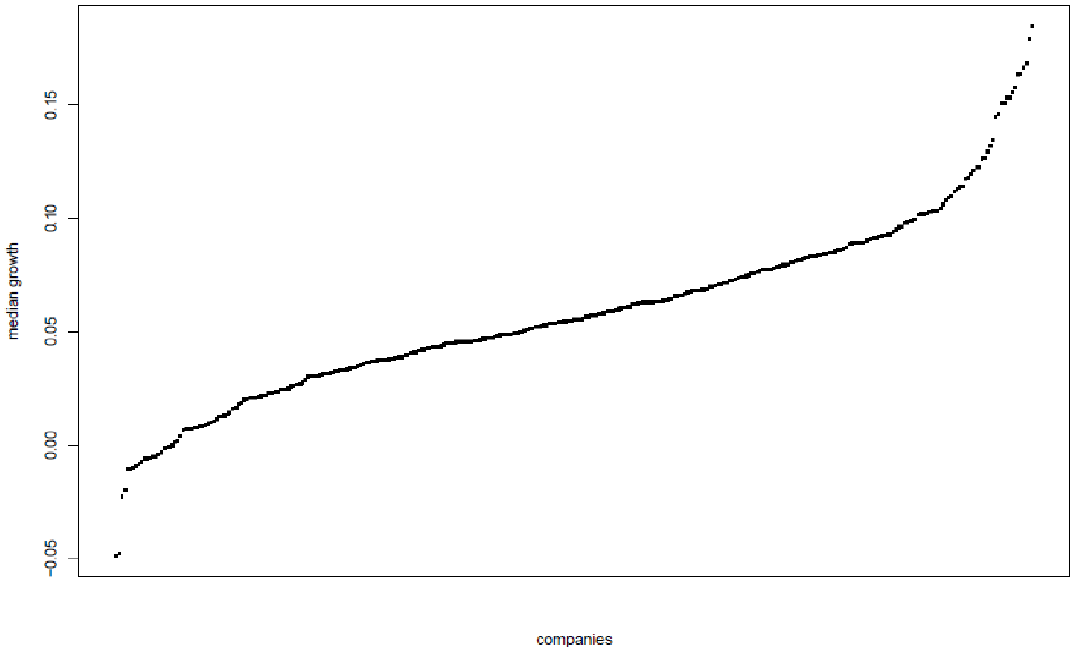
Figure 1: Annual median growth rate of US-Fortune 500 firms (1995–2015)